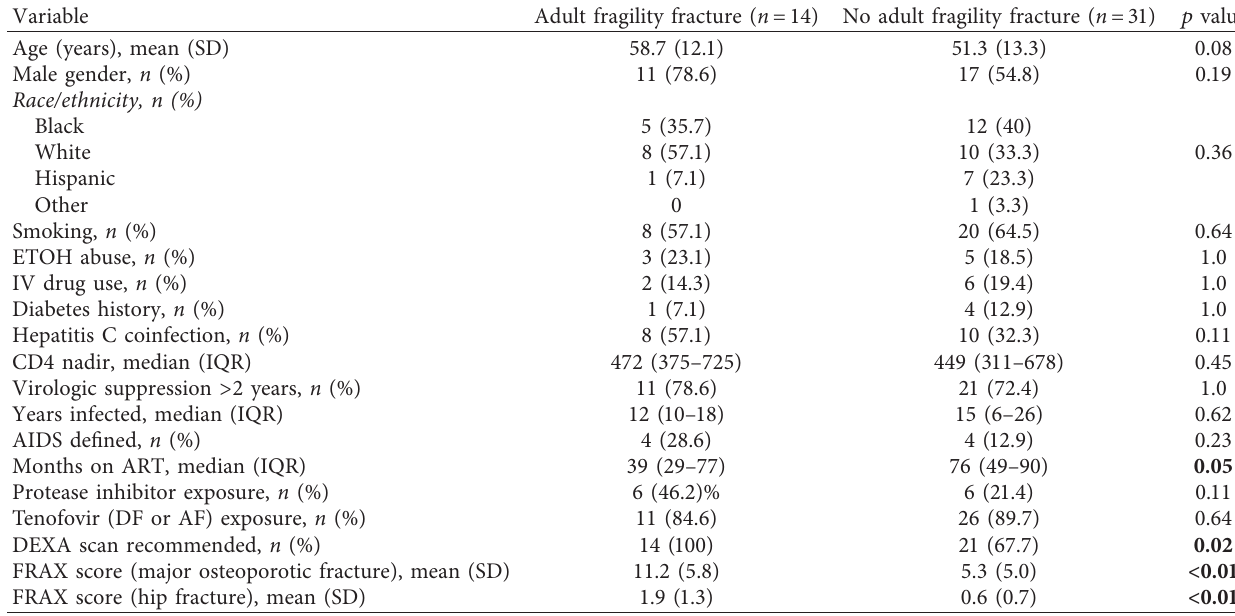
Table 2: Baseline demographics and characteristics.